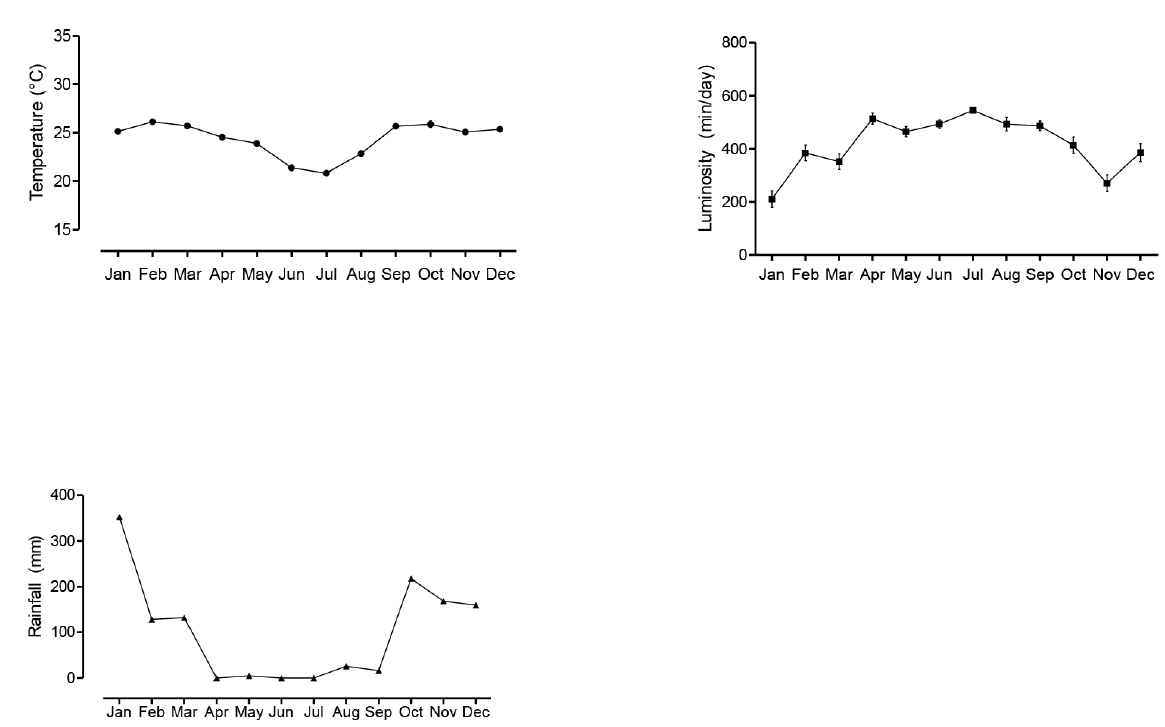
Figure 3. Monthly climate variations of air temperature (°C), luminosity (min/day) and rainfall (mm) from Cerrado biome, in 2016, in the region of